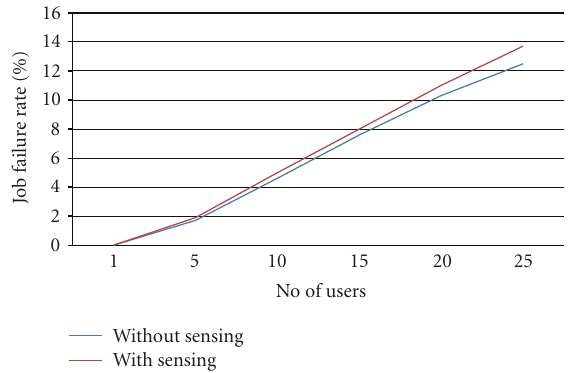
Figure 10: Performance of probability of false alarm using AND- rule cooperative sensing under various SNR conditions.